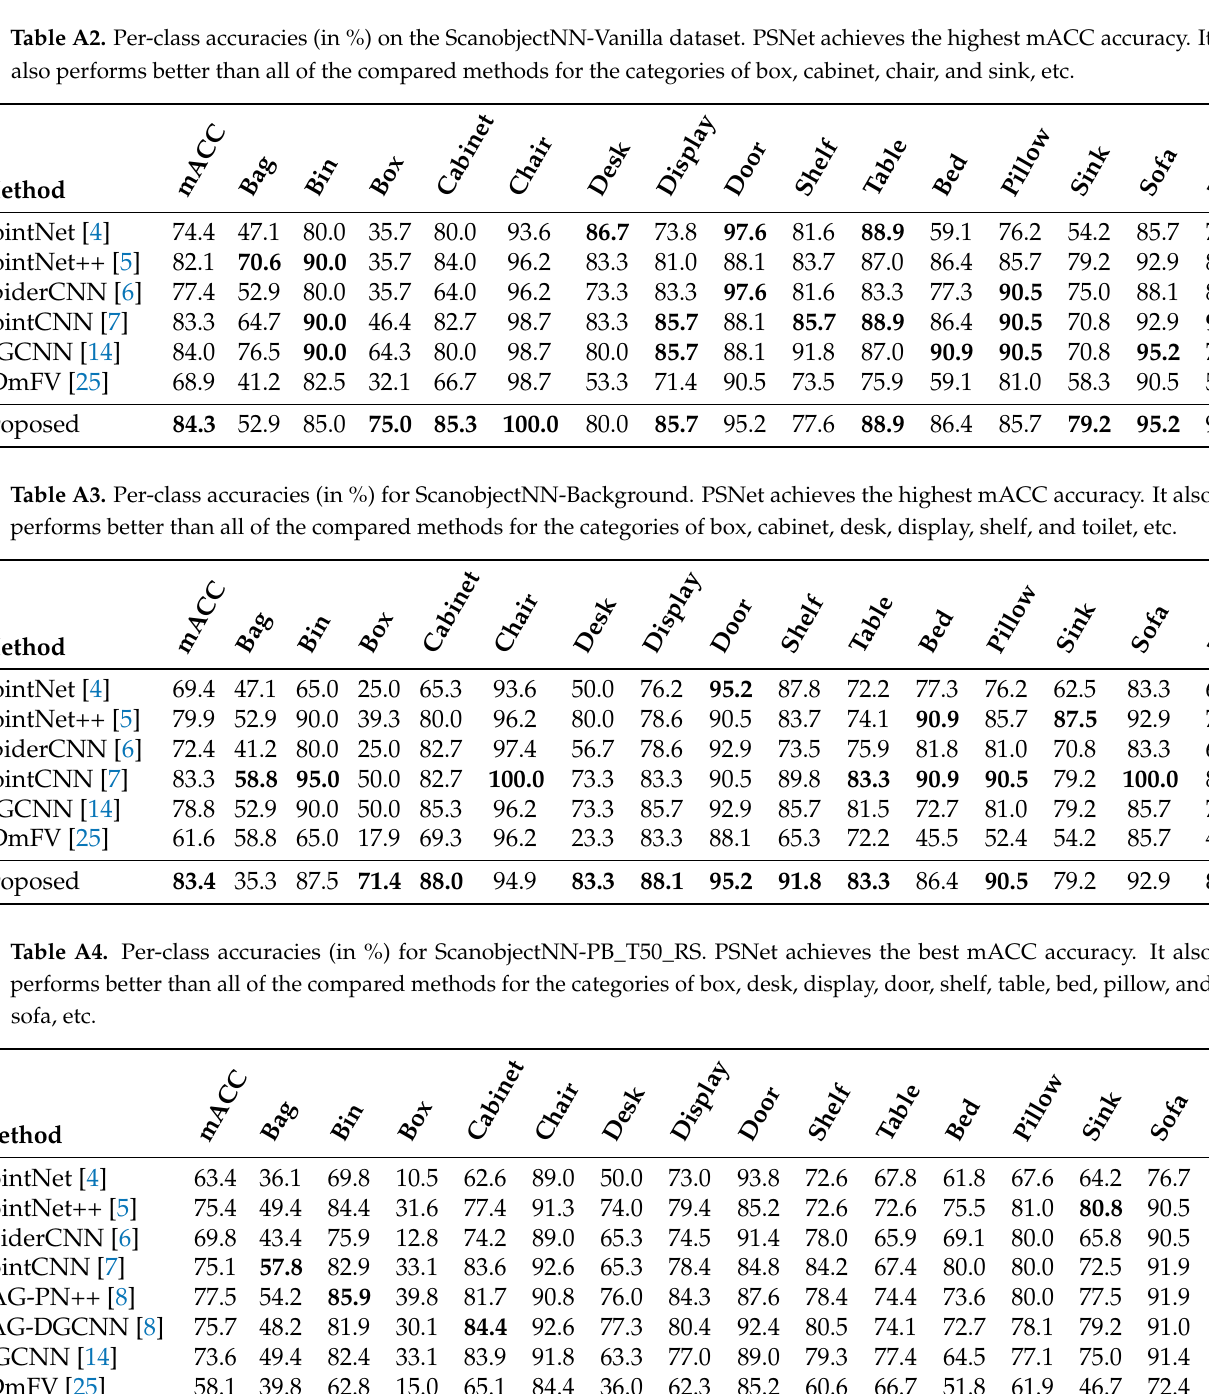
Table A2. Per-class accuracies (in %) on the ScanobjectNN-Vanilla dataset. PSNet achieves the highest mACC accuracy. It also performs better than all of the compared methods for the categories of box, cabinet, chair, and sink, etc.